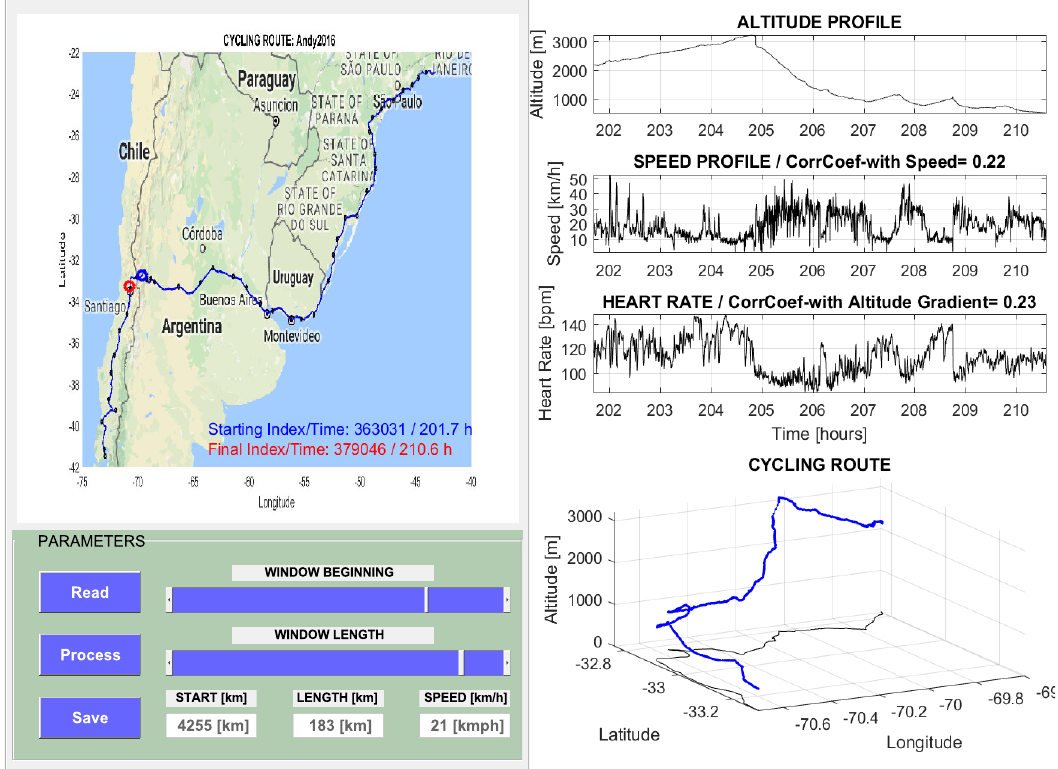
Figure 1. The use of the proposed graphical user interface for the analysis of a data segment 183 km long and a window beginning 4255 km after the expedition’s starting point, showing its position on the map and the signals recorded in this selected time/length region, along with some fundamental features of the segment.